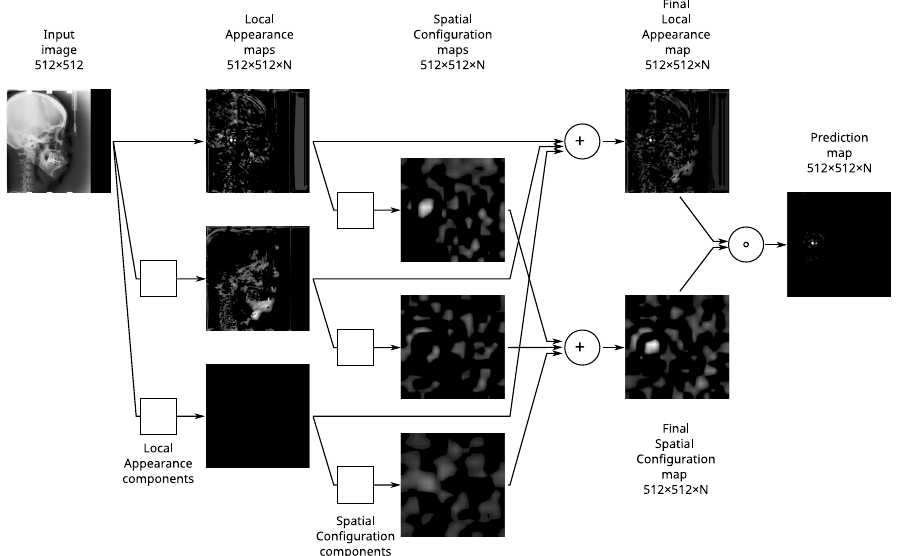
Figure 3. A rough block diagram of the proposed extended SpatialConfiguration-Net